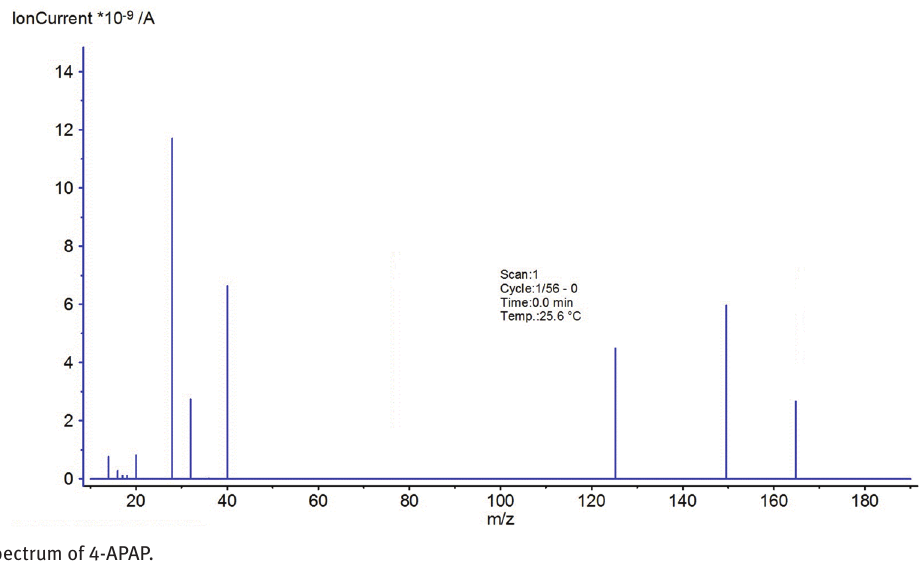
Figure 7: MS spectrum of 4-APAP.